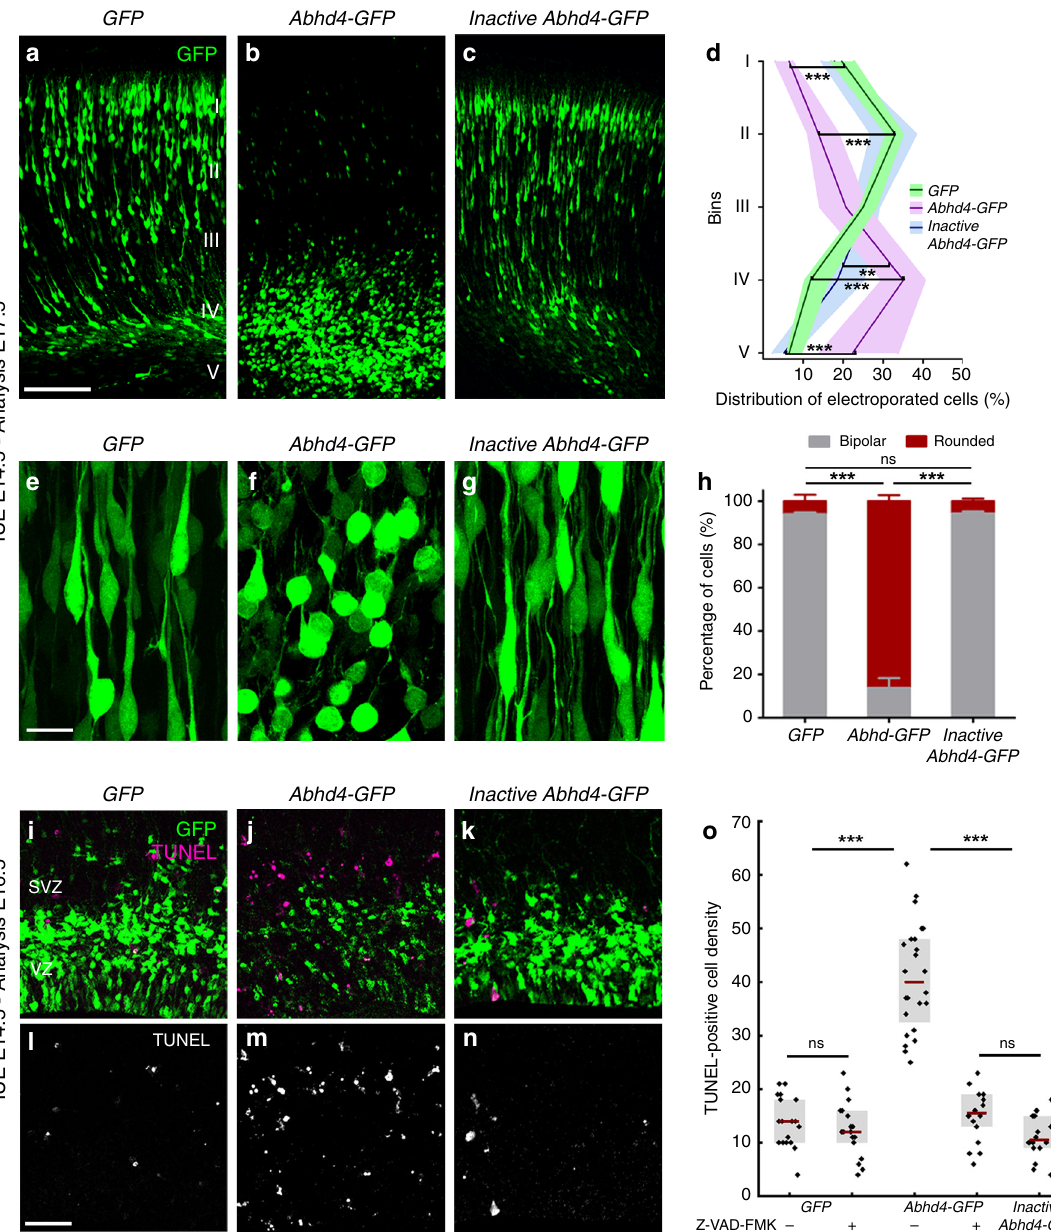
Fig. 5 ABHD4 is suf fi cient to trigger migration arrest and apoptosis. Cells in utero electroporated with GFP- ( a ), or with an Abhd4-GFP -construct encoding an enzymatically inactive form of ABHD4 ( c ) migrate into the cortical plate, whereas Abhd4-GFP -electroporation causes radial migration defect ( b ). d Laminar distribution of electroporated cells in fi ve equally-sized bins (Roman numerals) (Kruskal – Wallis test with post hoc Dunn ’ s test, 1st, 2nd, 4th, 5th bins for all comparisons: *** P < 0.0001, except 4th bin ( Inactive Abhd4-GFP vs Abhd4-GFP ): ** P = 0.006; n = 19 sections from n = 4 animals per GFP - electroporation; n = 18 sections from n = 4 animals per Abhd4-GFP -electroporation; n = 12 sections from n = 3 animals per Inactive Abhd4-GFP - electroporation). Data are shown as median (line) and interquartile range (transparent band in the same color). High-power images show bipolar migrating neurons ( e , g ), that become rounded upon Abhd4-GFP -electroporation ( f ). h Quanti fi cation of cell morphology (Kruskal – Wallis test with post hoc Dunn ’ s test, *** P < 0.0001; ns = not signi fi cant, P ≈ 1; n = 15 – 15 sections from n = 3 – 3 animals per treatment). Graphs show bar plots with median± interquartile range. i – n Representative images show large density of TUNEL-positive cells upon Abhd4-GFP electroporation in the subventricular (SVZ) and ventricular (VZ) zone ( j , m ), that is not replicated by GFP- ( i , l ), or by inactive Abhd4-GFP -electroporation ( k , n ). o Quanti fi cation of TUNEL-positive cell density (Kruskal – Wallis test with post hoc Dunn ’ s test, *** P < 0.0001; ns = not signi fi cant, P ≈ 1 except per Abhd4-GFP -electroporation with Z-VAD-FMK treatment vs Inactive Abhd4-GFP P = 0.607; n = 18 – 18 sections from n = 3 – 3 animals per GFP -electroporation with and without Z-VAD-FMK treatment and per Inactive Abhd4-GFP -electroporation; n = 24 sections from n = 4 animals per Abhd4-GFP -electroporation; n = 18 sections from n = 4 animals per Abhd4- GFP -electroporation with Z-VAD-FMK treatment). Graphs show box-and-whisker plots (including minima, maxima, and median values, lower and